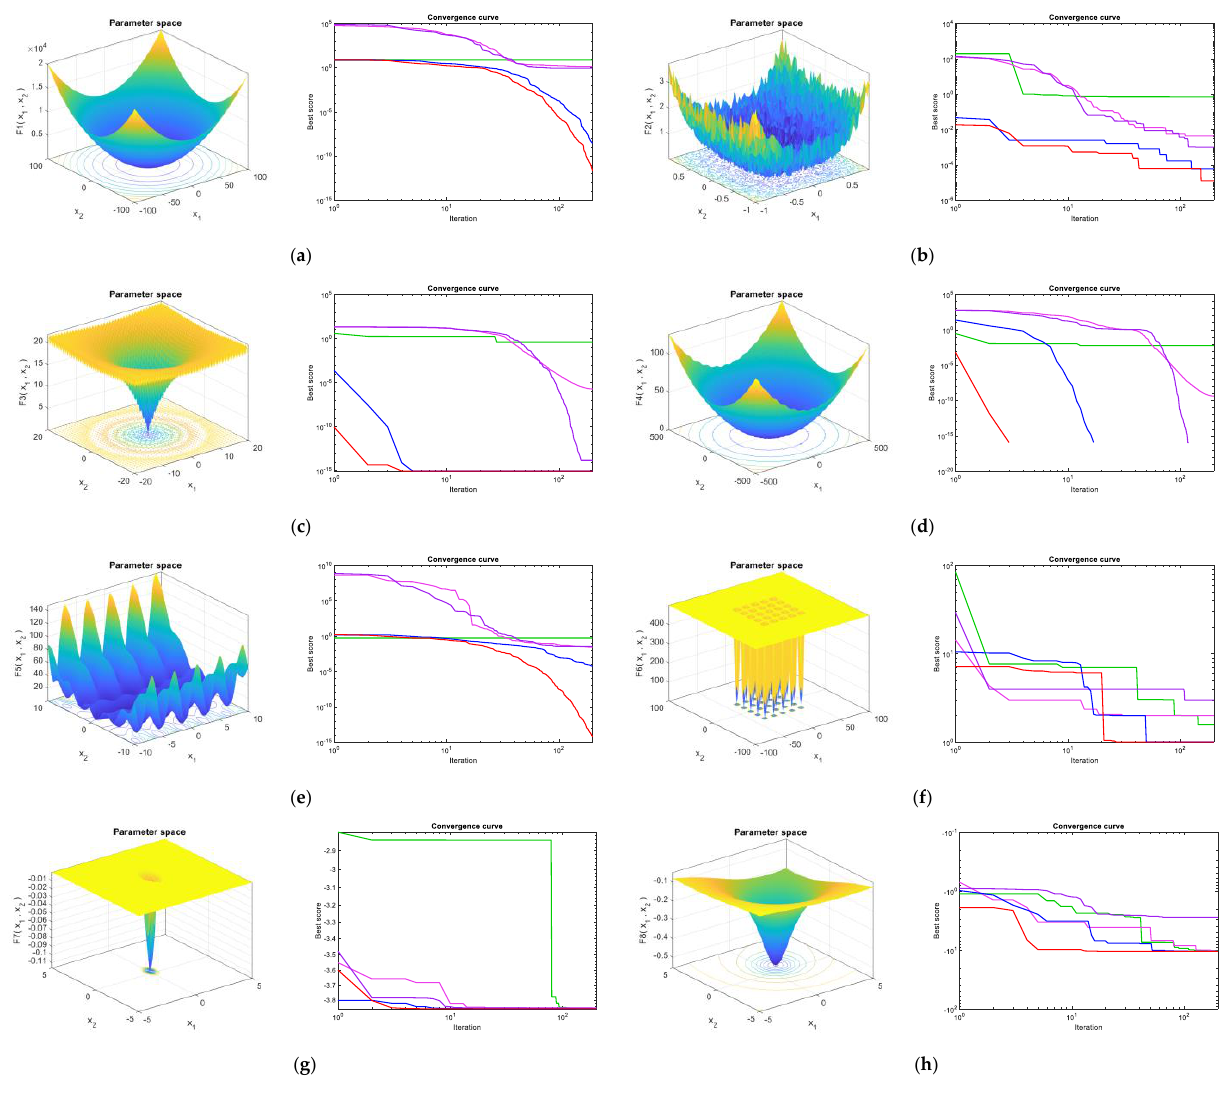
Figure 3. Qualitative metrics for the benchmark functions: 2D views and convergence curves of the